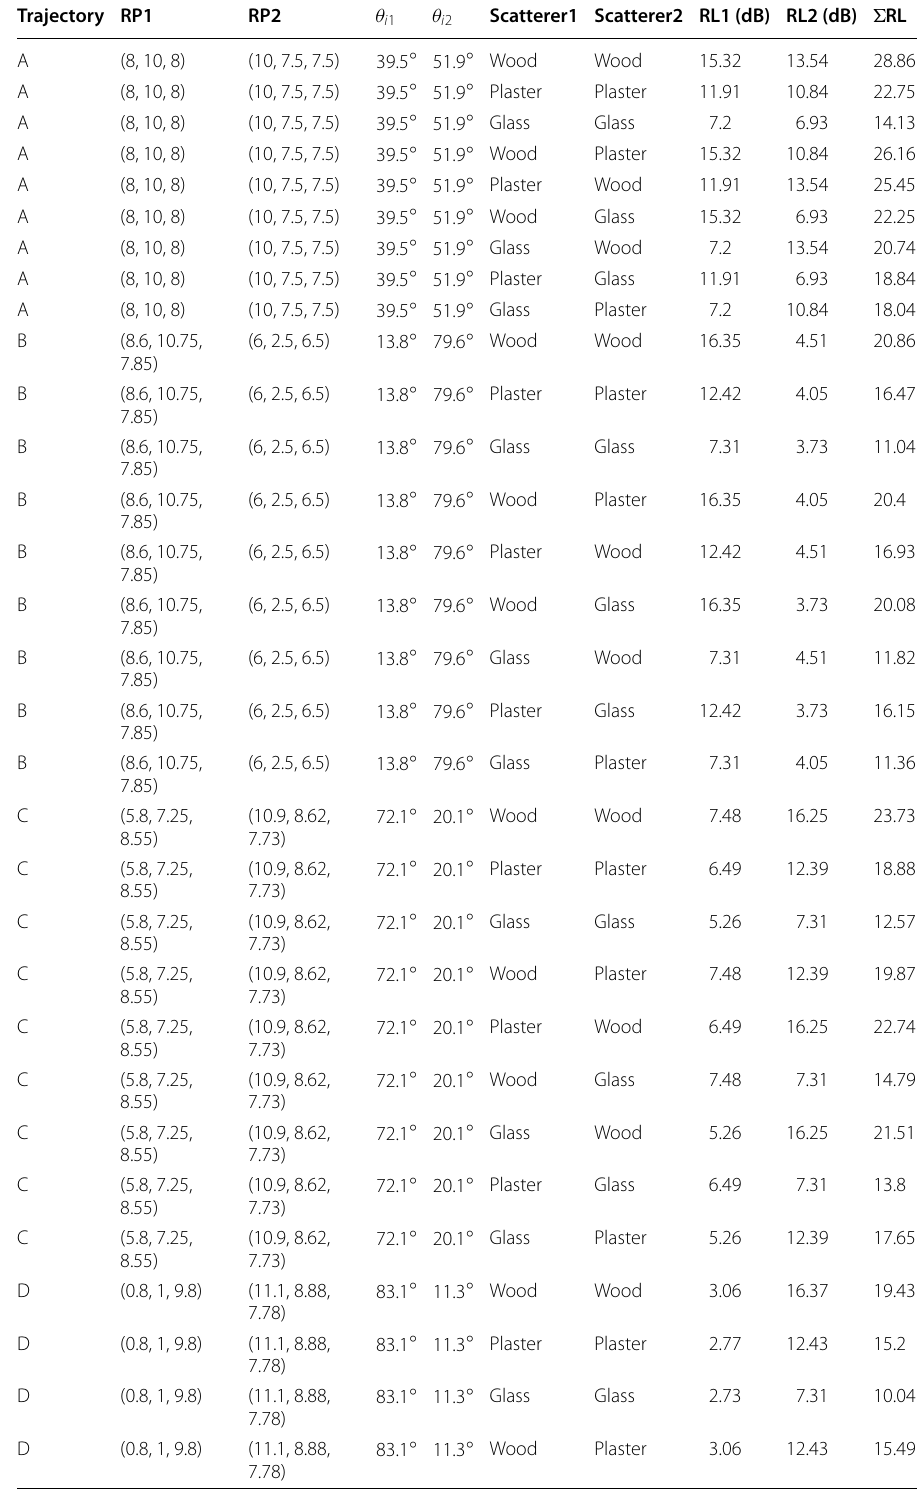
Table 3 Information about possible trajectories and scatterers after matching the overall path